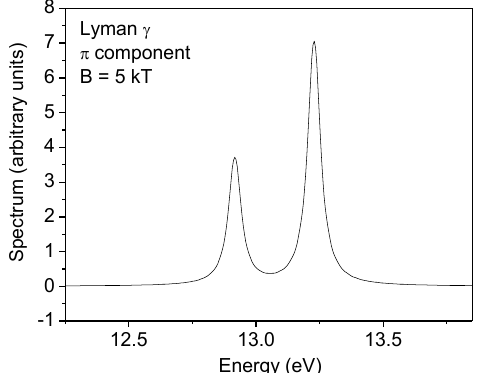
Figure 2. A feature of the quadratic Zeeman effect is the occurrence of forbidden components, namely such that the selection rule | ∆ l | = 1 is not satisfied. Here, this effect is illustrated on the π component of the Lyman γ line shape. The two components correspond to the 4p 0 -1s transition (allowed) and the 4f 0 -1s transition (forbidden). Other physical mechanisms of line broadening have not been retained and overlapping with neighboring lines has not been included for the sake of clarity. See text for details on the